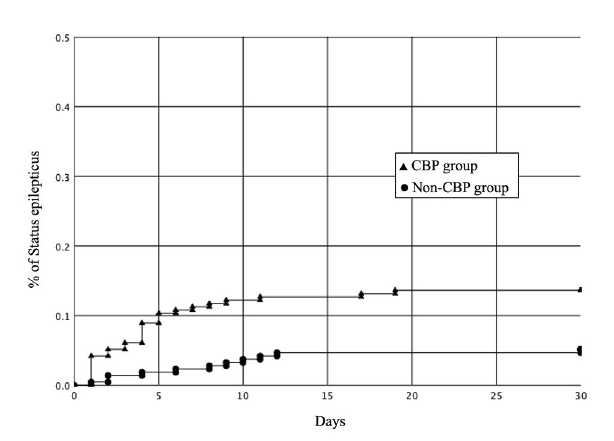
FIGURE2 Kaplan-Meier curves showing the rates of status epilepticus in the CBP and non-CBP groups after the concomitant administration (log-rank P = 0.001). CBP, carbapenem